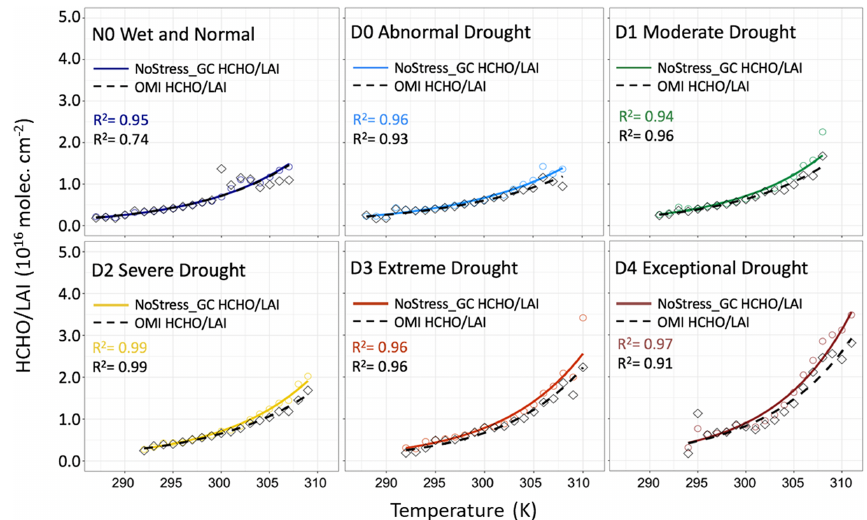
Figure 7. Response of the HCHO / LAI ratio (10 16 molec.cm − 2 ) to temperature (K) for different drought levels averaged over JJA 2005– 2017. The colored solid line is the modeled NoStress_GC HCHO / LAI ratio, and the black dashed line is the observed HCHO / LAI ratio from OMI. The exponentially fitted formulas and the resulting coefficient of determination ( R 2 ) are labeled in each subplot. Table 1. Fitted exponential formulas of the NoStress_GC and the OMI HCHO / LAI ratios ( (cid:127) , 10 16 molec.cm − 2 ) to surface air temperature ( T , K) as well as the fitted value of the HCHO / LAI ratio at 290, 300, and 310K. USDM NoStress_GC HCHO / LAI ( (cid:127) , 10 16 molec.cm − 2 ) OMI HCHO / LAI ( (cid:127) , 10 16 molec.cm − 2 ) Fitting formula 290K 300K 310K Fitting formula 290K 300K 310K N0 ln (cid:127) = 0 . 104 T − 31 . 42 0.25 0.72 2.03 ∗ ln (cid:127) = 0 . 101 T − 30 . 78 0.26 0.72 1.97 ∗ D0 ln (cid:127) = 0 . 091 T − 27 . 83 0.27 0.67 1.66 ln (cid:127) = 0 . 085 T − 25 . 92 0.26 0.60 1.40 D1 ln (cid:127) = 0 . 108 T − 32 . 83 0.24 0.71 2.10 ln (cid:127) = 0 . 100 T − 30 . 56 0.23 0.64 1.74 D2 ln (cid:127) = 0 . 110 T − 33 . 33 0.24 0.71 2.14 ln (cid:127) = 0 . 098 T − 29 . 97 0.24 0.65 1.75 D3 ln (cid:127) = 0 . 118 T − 35 . 72 0.24 0.78 2.56 ln (cid:127) = 0 . 121 T − 36 . 62 0.20 0.67 2.23 D4 ln (cid:127) = 0 . 125 T − 37 . 59 0.26 0.90 3.13 ln (cid:127) = 0 . 115 T − 34 . 62 0.26 0.83